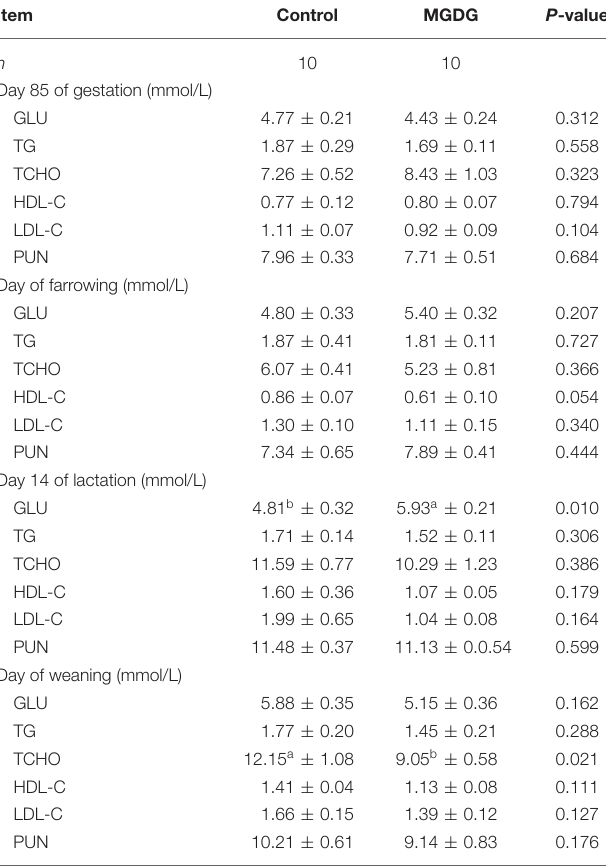
TABLE 8 | Effects of dietary MGDG supplementation during late gestation and lactation on sow plasma constituent concentrations. Item Control MGDG P